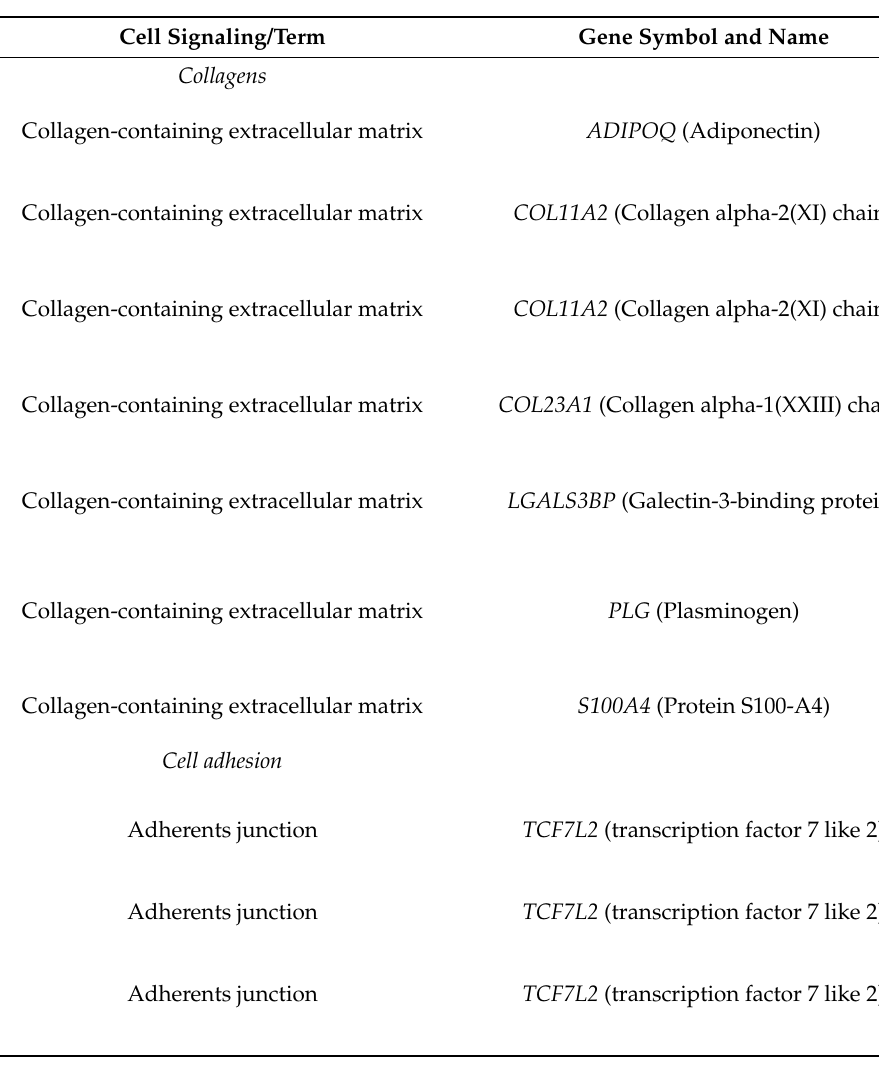
Table 2. DNA methylation approaches reveal the implication of ECM in obesity and metabolic